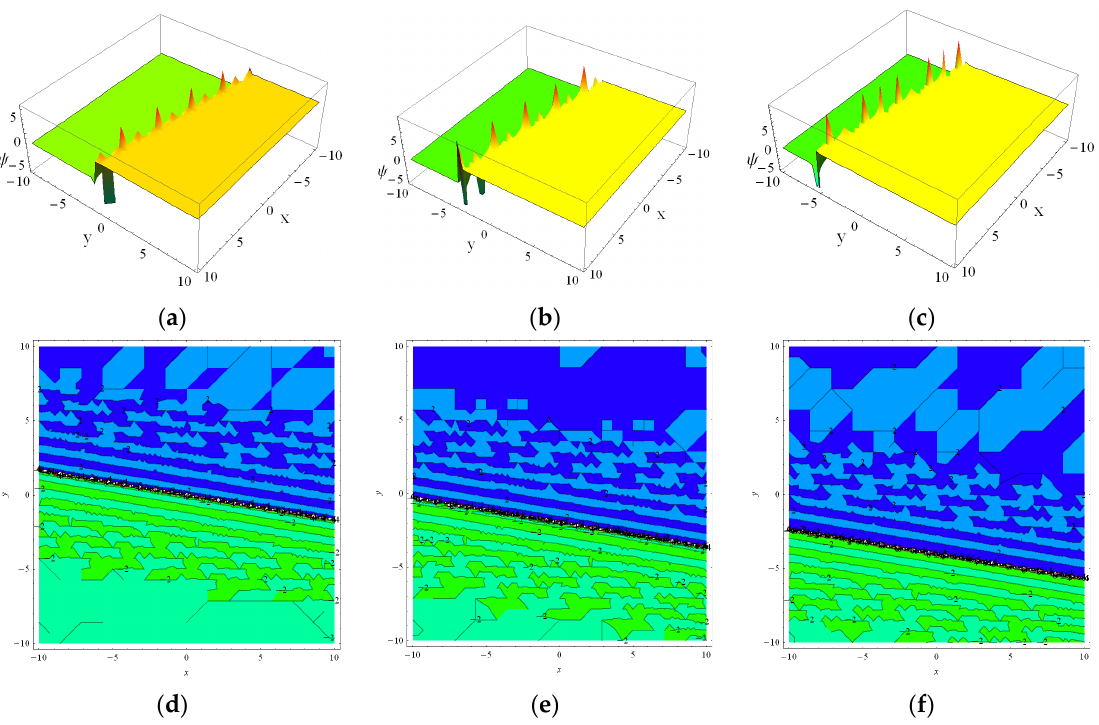
Figure 1. The 3-D plots and 2-D contours of Equation (6) with the parameters as ε 2 = 2, ε 9 = 3, ∆ = 1, ∆ = − 1, ∆ = 1, and ∆ = 1 at z = 0. ( a , d ) for t = 0, ( b , e ) for t = 4, ( c , f ), and for t = 8. 2 3 1 4